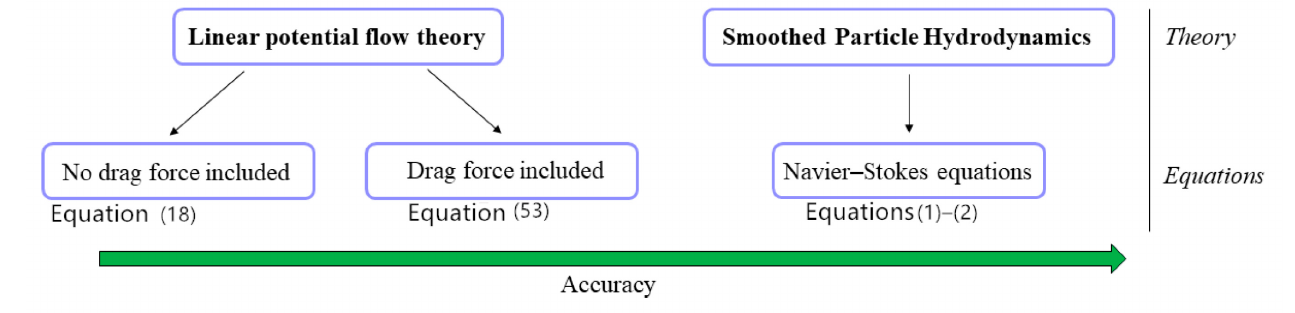
Figure 1. Schematic overview of the applied theories and equations in the current